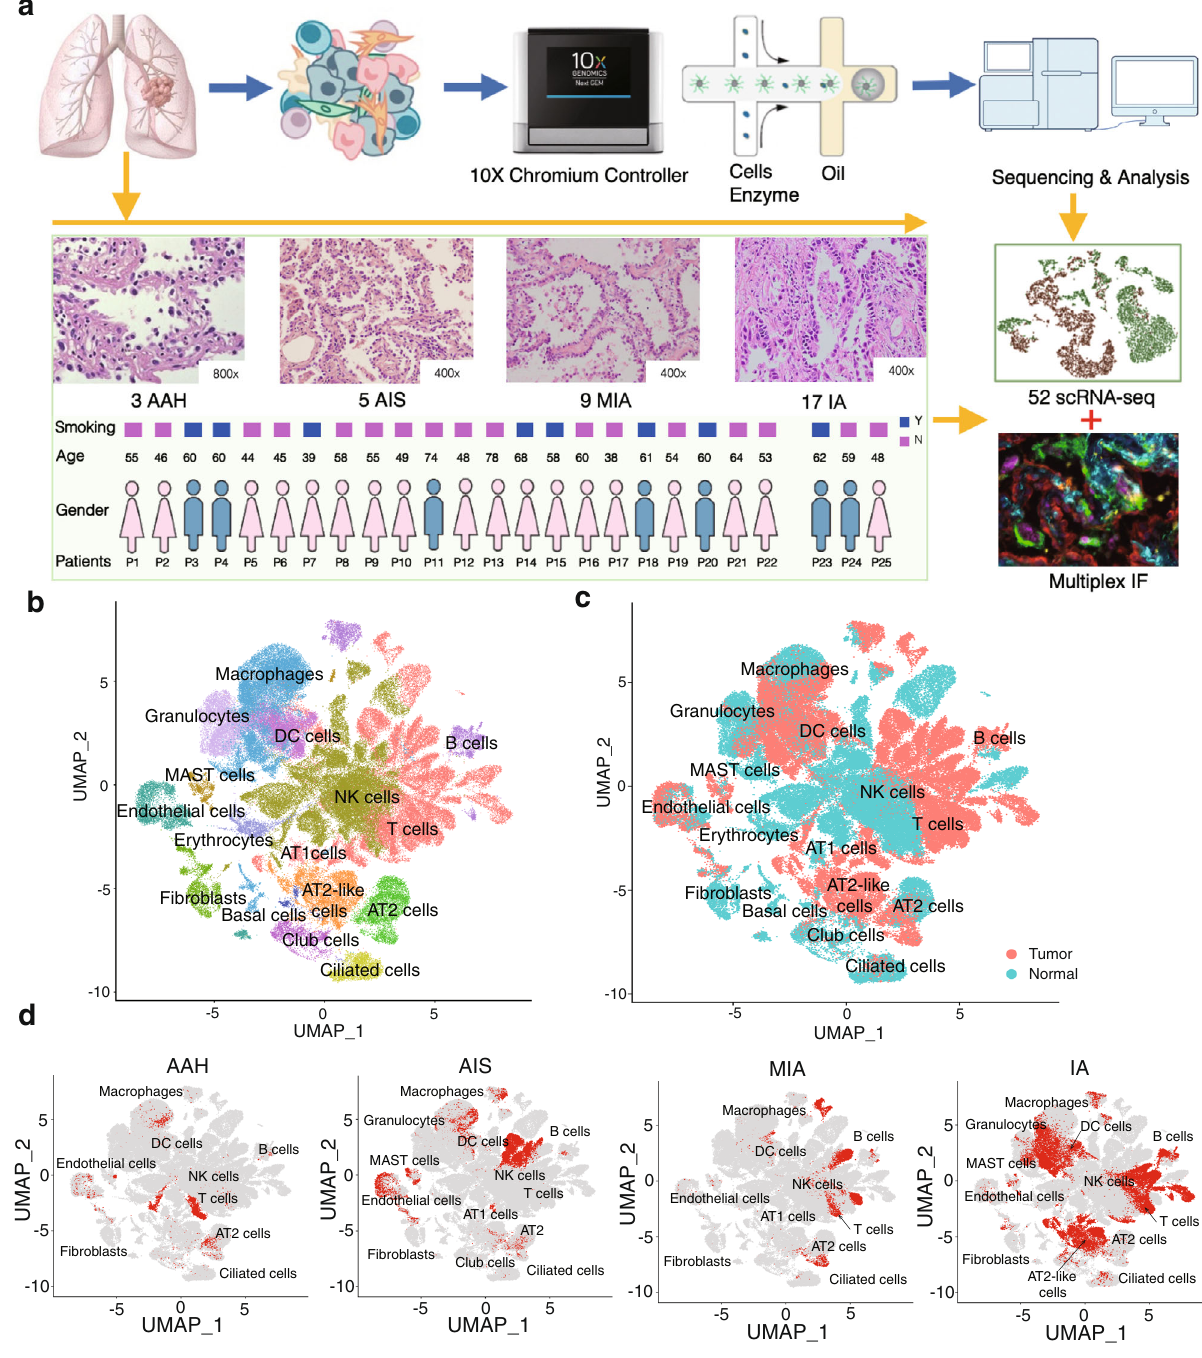
Fig. 1 Overview of the single-cell transcriptomic pro fi le of LUAD samples. a Schematic experimental work fl ow for the study. A total of 34 freshly resected lung tumor specimens were collected from 25 patients, and normal lung tissues were collected from 18 patients as controls. Samples from patients 1 to 22 were processed using 10X Chromium V2 kits, while samples from patients 23 to 25 were used as the validation dataset and